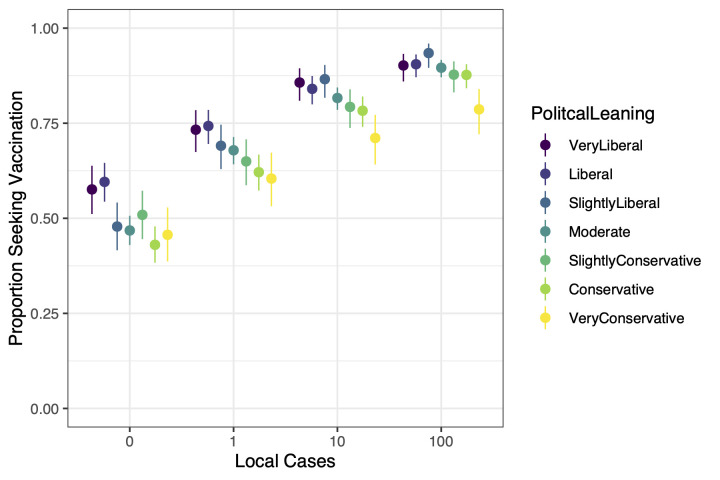
Comparing ideologies in proportion willing to seek vaccination across 4 levels of risk.Visual inspection suggests a rough trend that the conservative end of the ideology spectrum has a lower proportion willing to seek vaccination than the liberal end. Exact values can be found in Table 4. It is noteworthy to compare the very liberal, the very conservative, and the moderate. When risk is lowest at zero local cases, moderate respondents are similar to conservative and very conservative respondents. When risk is highest at 100 local cases, moderate respondents are similar to the liberal ends of the spectrum. The moderate population thereby exhibits a higher responsiveness to changes in risk. The points are offset from 0, 1, 10, and 100 as a visual aid. Whiskers from the points are the 95% confidence intervals.